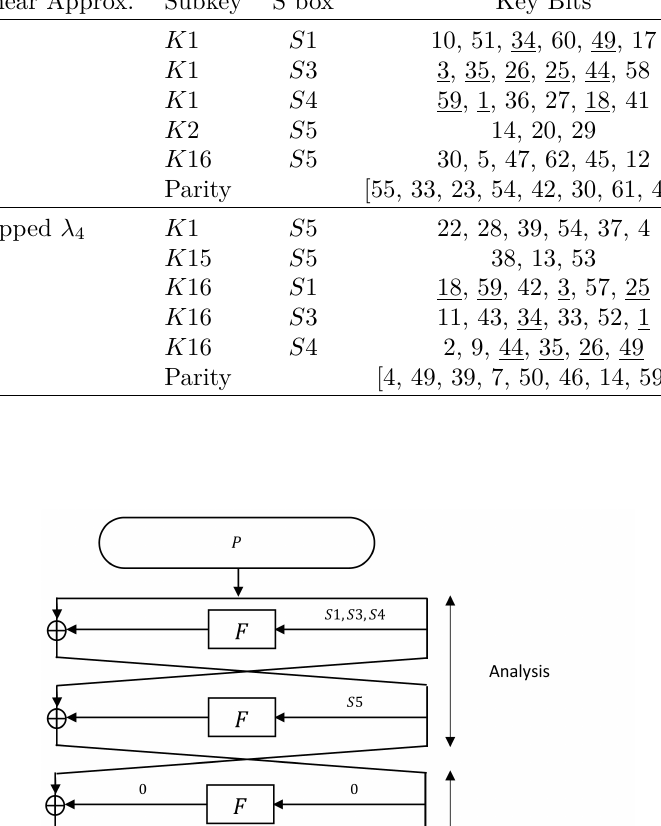
Table 15: The Key Bits Involved in the Two Conditional Linear Approximations Used in the Attack (the underlined bits are common to both approximations) Linear Approx. Subkey S box Key Bits